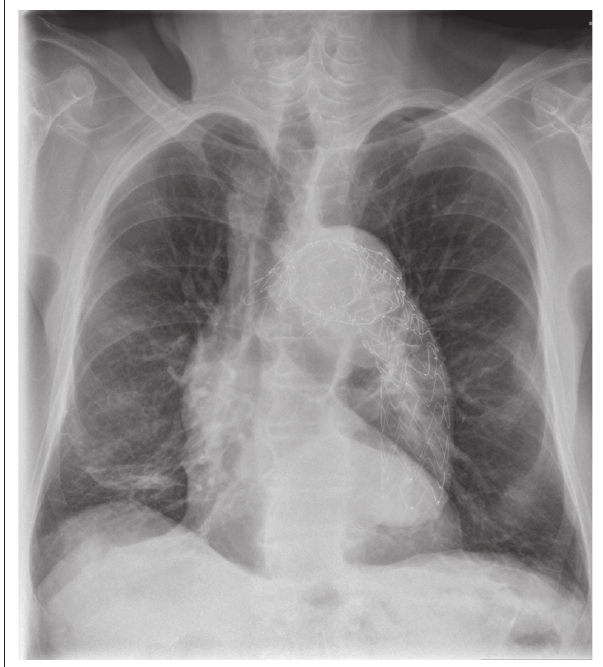
FIGURE 13: Endovascular stent graft in the thoracic aorta of a 75-year-old man, placed after aneurysm repair.